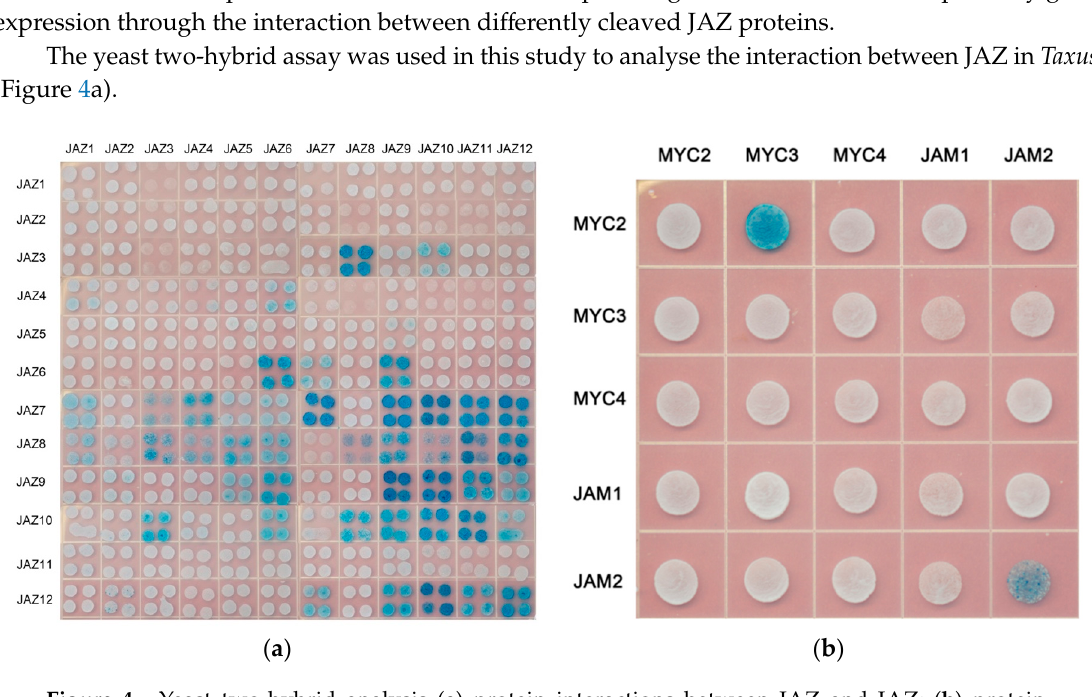
Figure 4. Yeast two-hybrid analysis ( a ) protein interactions between JAZ and JAZ; ( b ) protein interactions between MYC-type transcription factors.